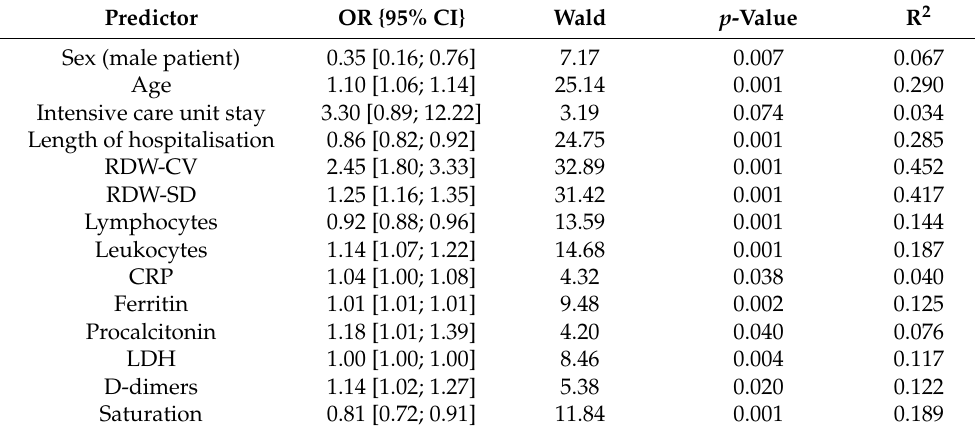
Table 2. Analysis of relationships between potential predictors and mortality. Predictor